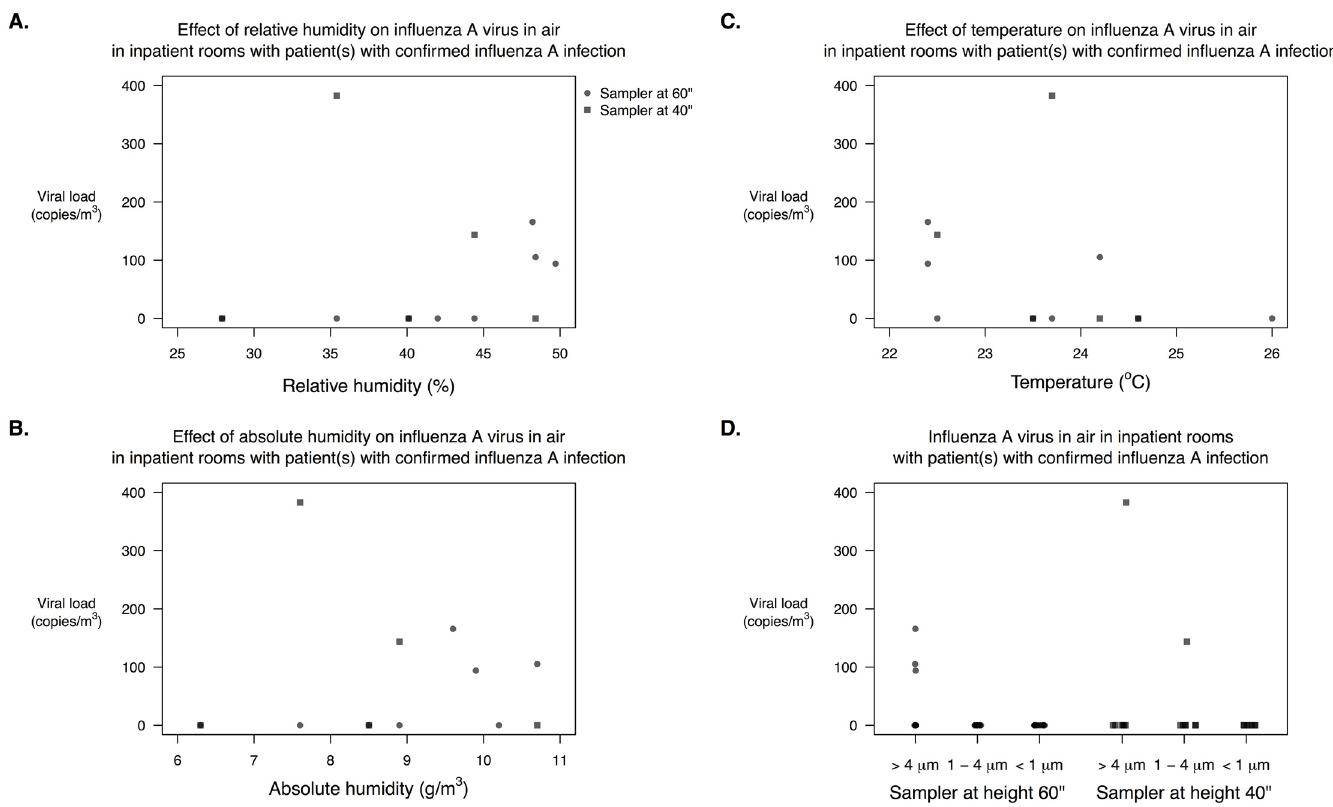
Fig 2. Scatter plots of the concentration of influenza virus RNA detected in the air (influenza virus RNA particles/m 3 of air) versus relative humidity (A), absolute humidity (B), temperature (C) and the height of the sampler (D). Dot indicates the concentration of RNA copies of influenza virus recovered from a sampler set at 1.5 m from the floor, and square indicates that from a sampler set at 1.0 m from the floor.